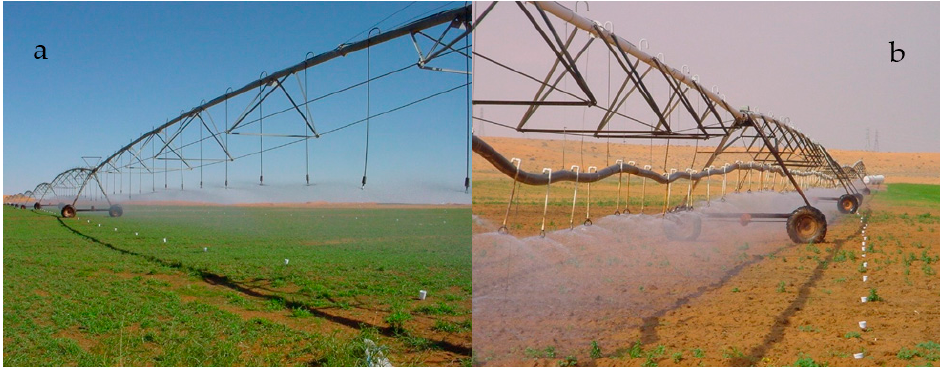
Figure 3. Two types of center pivot irrigation systems employed in the study regions with standard lateral ( a ) and modified lateral ( b ).